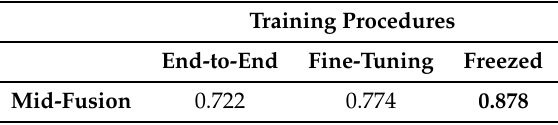
Table 7. Comparison of different training procedures for the mid-level fusion strategy combining RGB, infrared and depth